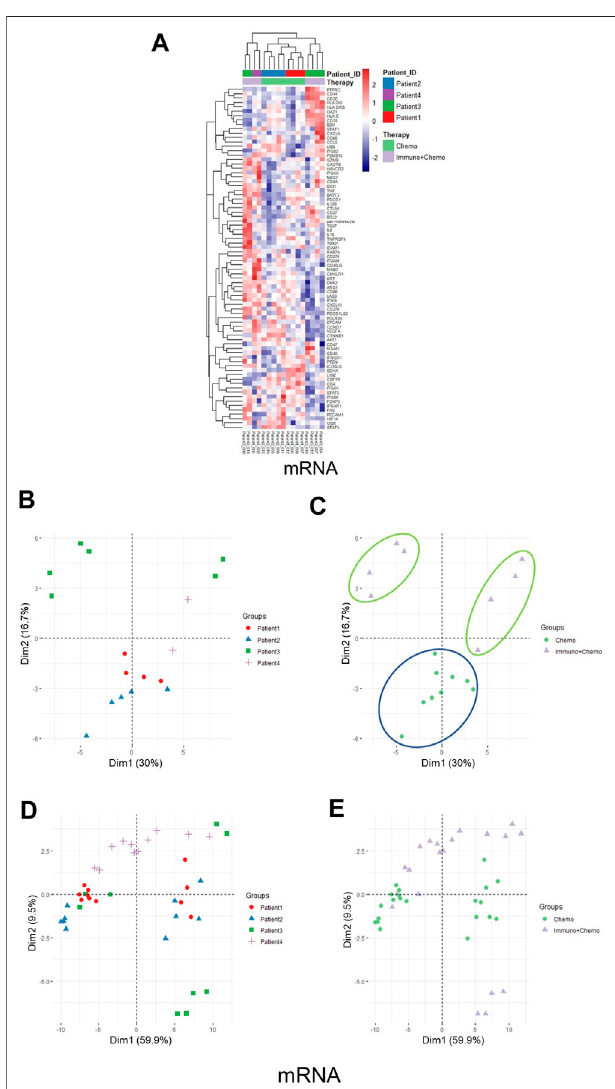
FIGURE 6 | Unsupervised hierarchical clustering and PCA of stromal regions based on mRNA expression and all ROI clustering. (A) Unsupervised hierarchical clustering of mRNA expression in the stroma ROIs of chemotherapy or combinational therapy patients. ROIs are grouped based on treatment options and patient IDs. (B,C) PCA plots of mRNA expression in the stroma ROIs grouped by patients (B) or therapies (C) , respectively. (D,E) PCA plots of mRNA expression in all ROIs (tumor and stroma) grouped by patients (D) or therapies (E) , respectively.